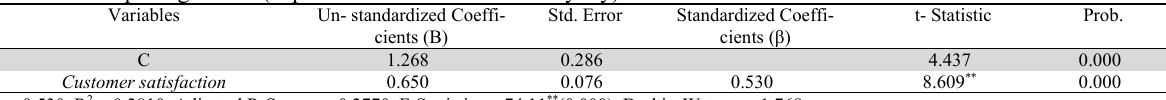
Results of simple regression (dependent variable customer loyalty)